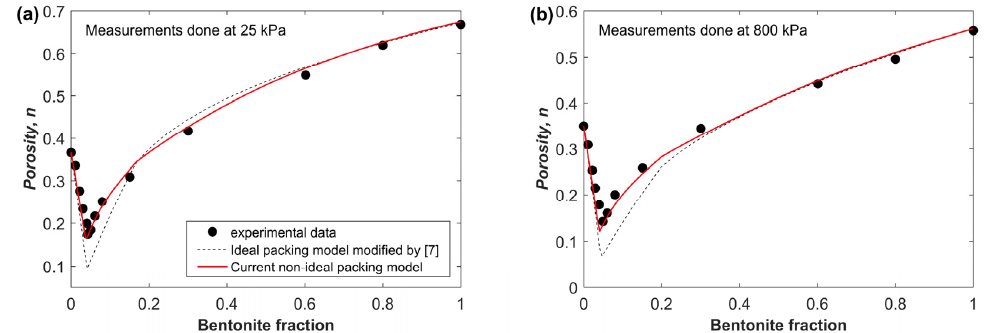
Figure 7. Porosity as function of bentonite fraction for a mixture of Fujian sand and bentonite where data were measured by Xu et al. [7] under pressure of ( a ) 25 kPa and ( b ) 800 kPa. Red curve correspond to the prediction from the current model (Equations (7)–(9) and (10)–(12)) while the dashed black curve represents the prediction from the modified ideal packing model by Xu et al. [7].